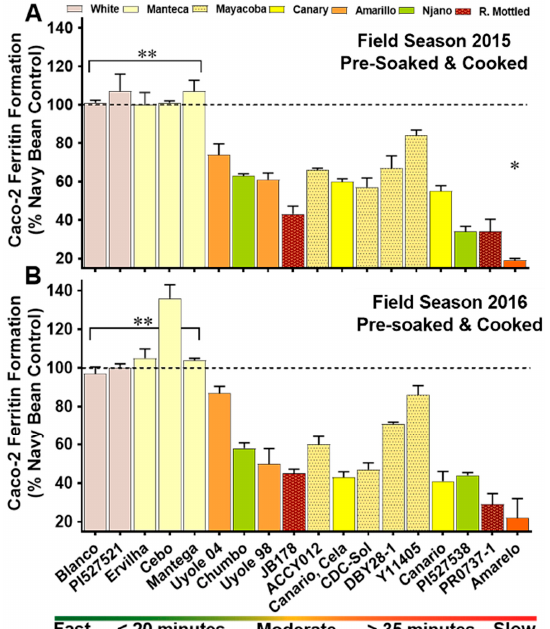
Figure 3. Iron bioavailability scores of pre-soaked and cooked whole seed genotypes in the YBP for field season 2015 ( A ) and field season 2016 ( B ). Values are means ( ± Standard Deviation) of triplicate measurements from two field replicates per genotype ( n = 6). Genotypes are categorized on the x-axis by cooking class, ranked from the fastest cooking genotype to slowest cooking entry. * Significantly lower ( p ≤ 0.05) iron bioavailability score when compared to the other YBP entries. ** Significantly higher ( p ≤ 0.05) iron bioavailability scores compared to the other YBP genotypes.